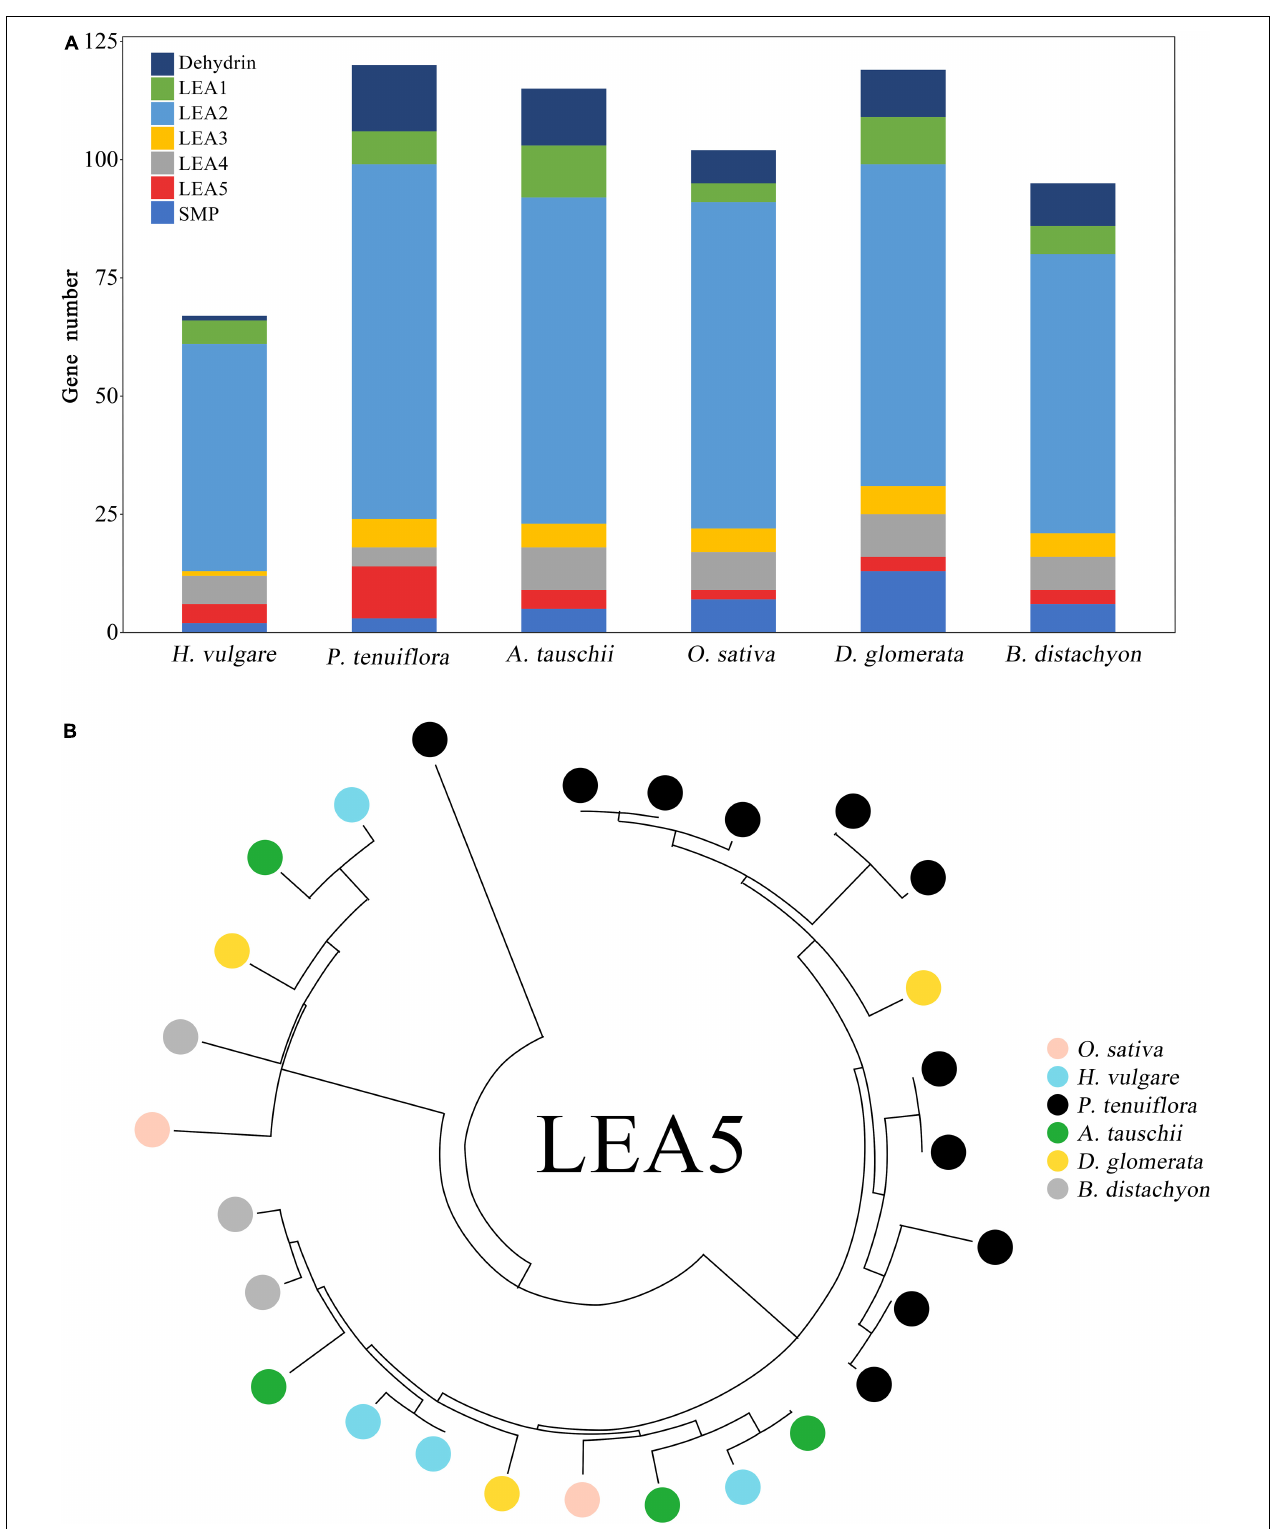
FIGURE 4 | LEA superfamily of P. tenuiflora . (A) Comparison of the member numbers of the LEA superfamily in P. tenuiflora , D. glomerata , rice, H. vulgare , B. distachyon , and A. tauschii . (B) Polygenetic tree of the LEA5 families in P. tenuiflora , D. glomerata , rice, H. vulgare , B. distachyon , and A. tauschii . Polygenetic tree constructed by MEGA-X using the Neighbor-Joining